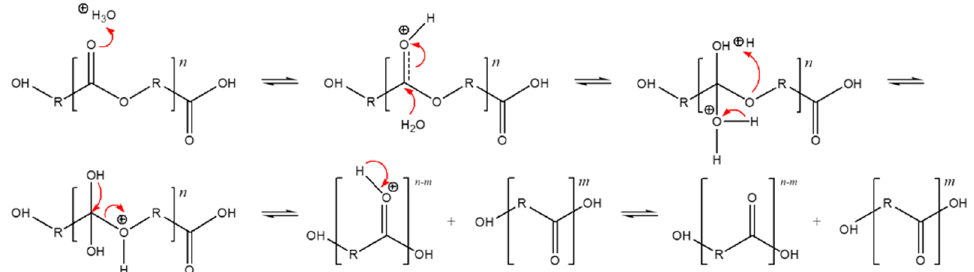
Figure 2. Soil degradation of ( a ) PHB and ( b ) PHBV aged in soil saturated with H 2 O (100% RH) for 0, 3, 7, and 10 days, and ( c ) PHB and ( d ) PHBV aged in soil kept at 40% RH for 6 weeks. Figure 3. Acid-catalyzed hydrolysis reaction of polyesters, originally published in [42].